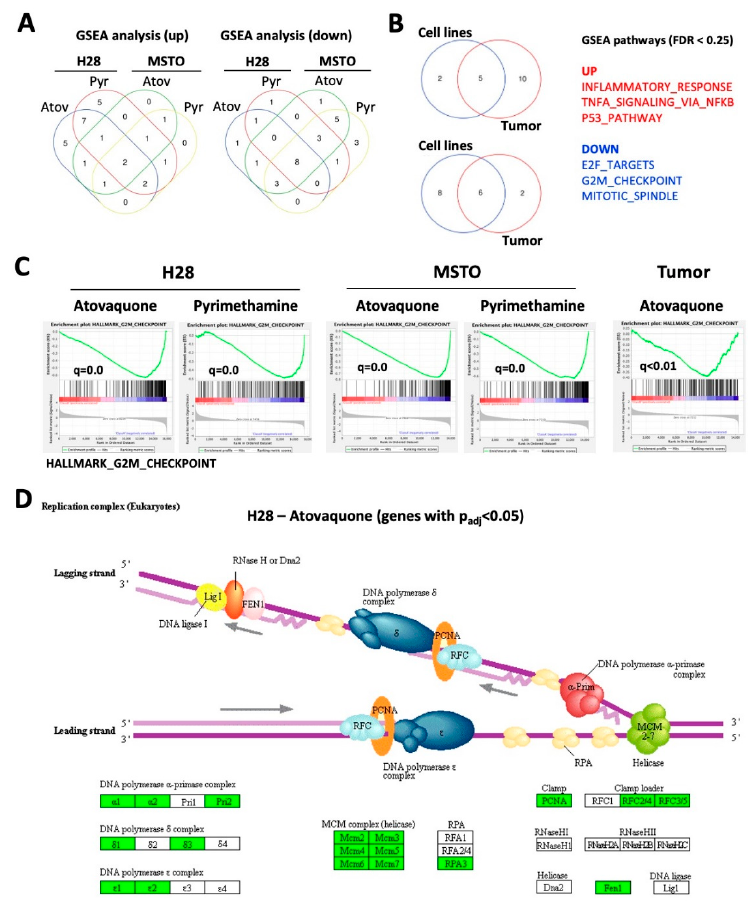
Figure 4. Atovaquone and pyrimethamine regulate pathways involved in cell growth. RNAseq data from H28 ( n = 2), MSTO-211H (MSTO) ( n = 2) or MS4 mouse tumors ( n = 4) treated for 24 h with either pyrimethamine (10 mM), atovaquone (30 mM) or vehicle were used. ( A ) Gene Set Enrichment Analysis (GSEA) pathway analysis was performed to identify pathways that were upregulated or downregulated in treated cell lines. The Venn diagram indicates the number of common pathways in the various models (FDR < 0.25). ( B ) GSEA pathways that were identified in at least three cell line models were compared to GSEA pathways identified in atovaquone-treated MS4 tumors (FDR < 0.25). The Venn diagram identifies the number of common pathways and the three most prominent pathways are indicated. ( C ) Enrichment plots of the Hallmark G2M checkpoint pathway and q-values (FDR approach) for each model are shown. ( D ) Significantly changed genes (fold change >2 or <0.5; p <